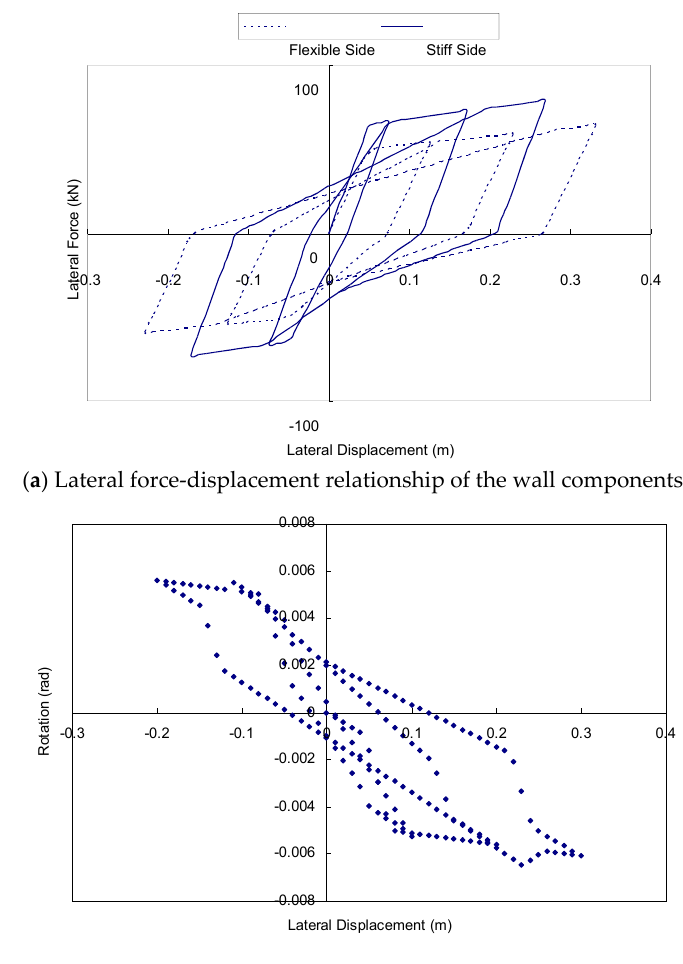
Figure 13. Response of the model problem subjected to cyclic static loading.